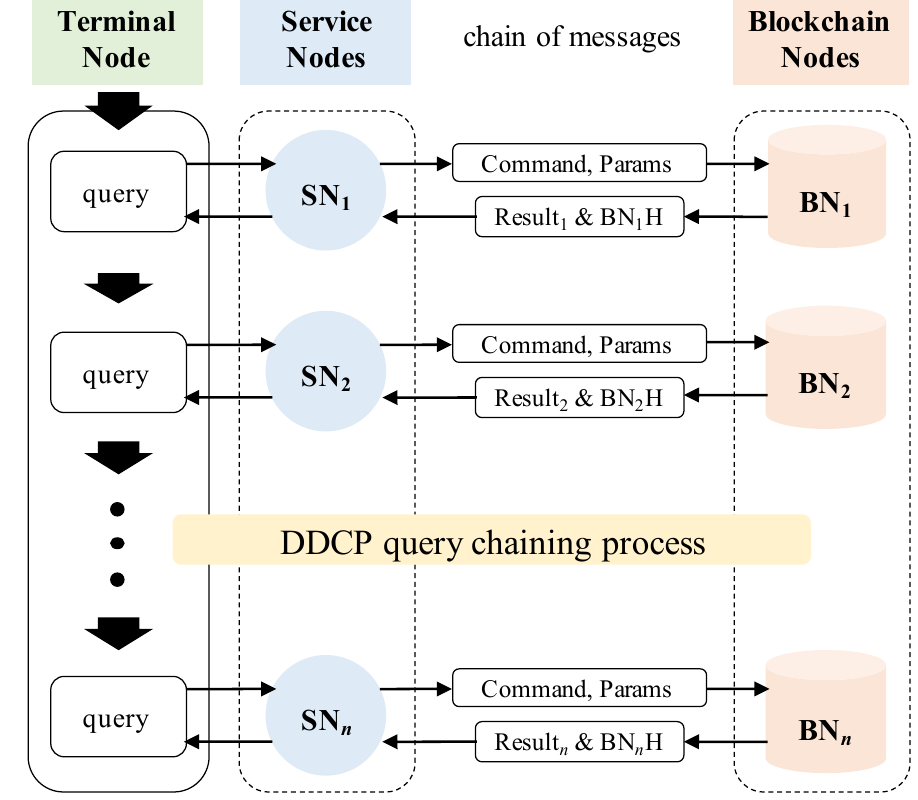
Figure 2. Dynamic Decentralized Certification Protocol